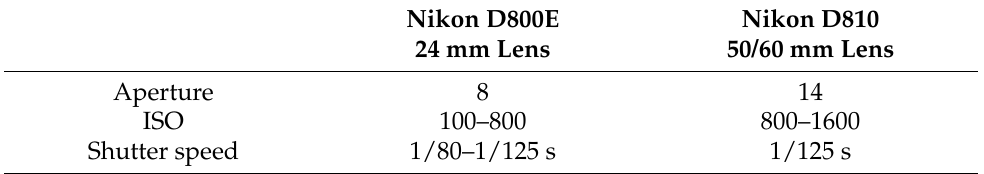
Table 3. Camera settings.